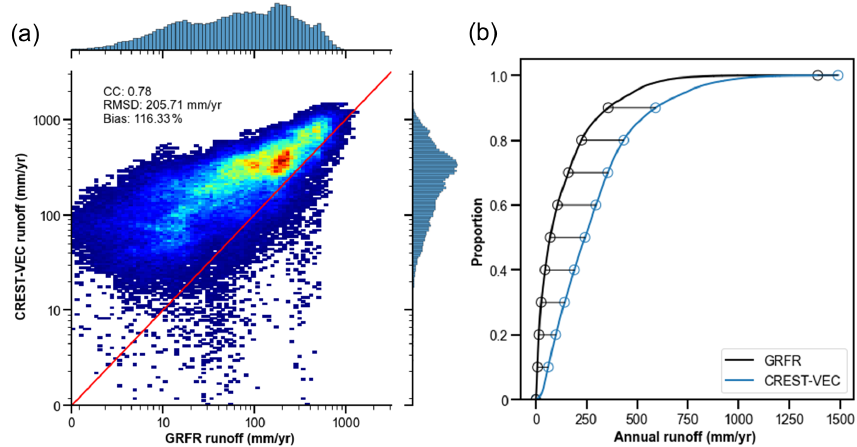
Figure 7. (a) Density plot of CREST-VEC simulated annual surface runoff against Global Reach-level Flood Reanalysis (GRFR) in the Great Plains. (b) CDF (cumulative density function) of CREST-VEC and GRFR simulated annual runoff.